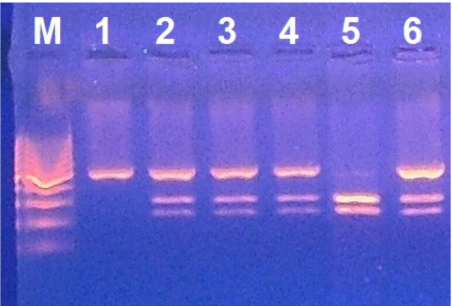
Figure 1. Identification of the G6PD Med mutation among CD patients by PCR and digestion with MboII enzyme. The mutated allele generates two fragments of 145 and 101 bp. M, marker; lane 1, normal; lanes 2, 3, 4, 6, heterozygote females; lane 5, hemizygote male (the PCR product band of 246 bp is